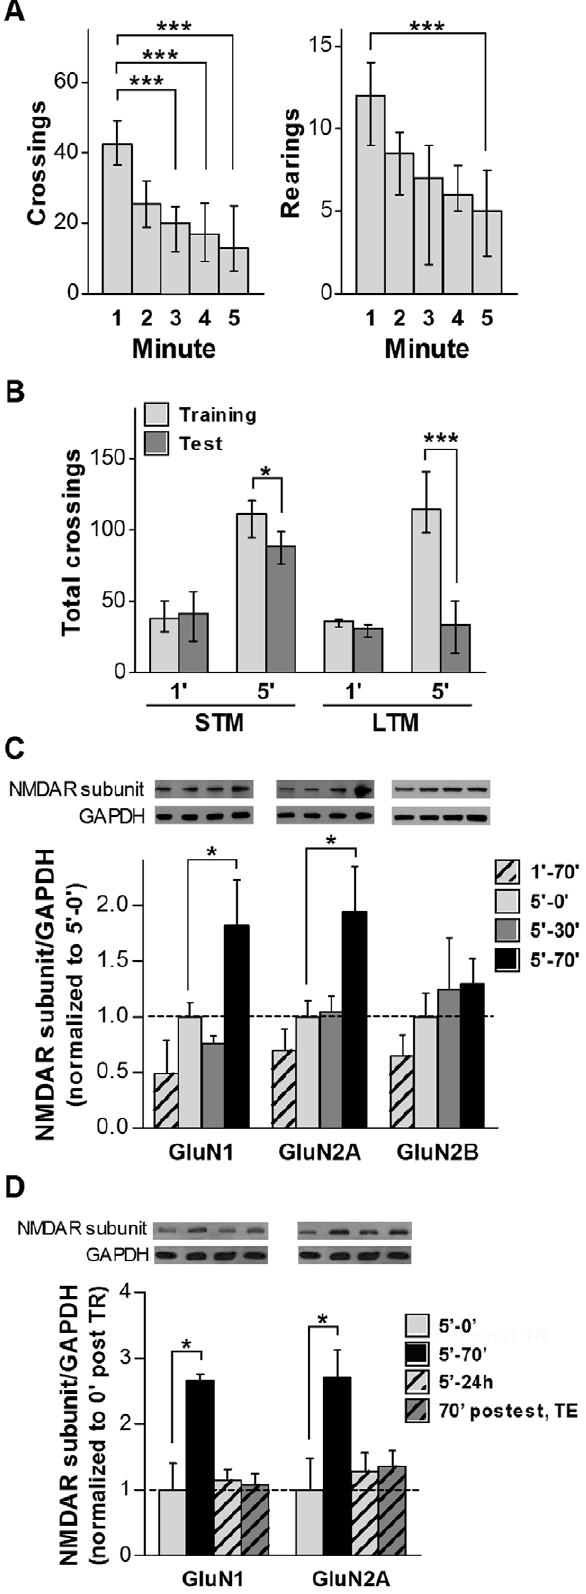
Figure 1. NMDAR subunits changes after OF habituation. A. Habituation to the OF of rats exposed to a 5 minutes OF session (n=16). Graphs show number of crossings (left panel) and rearings